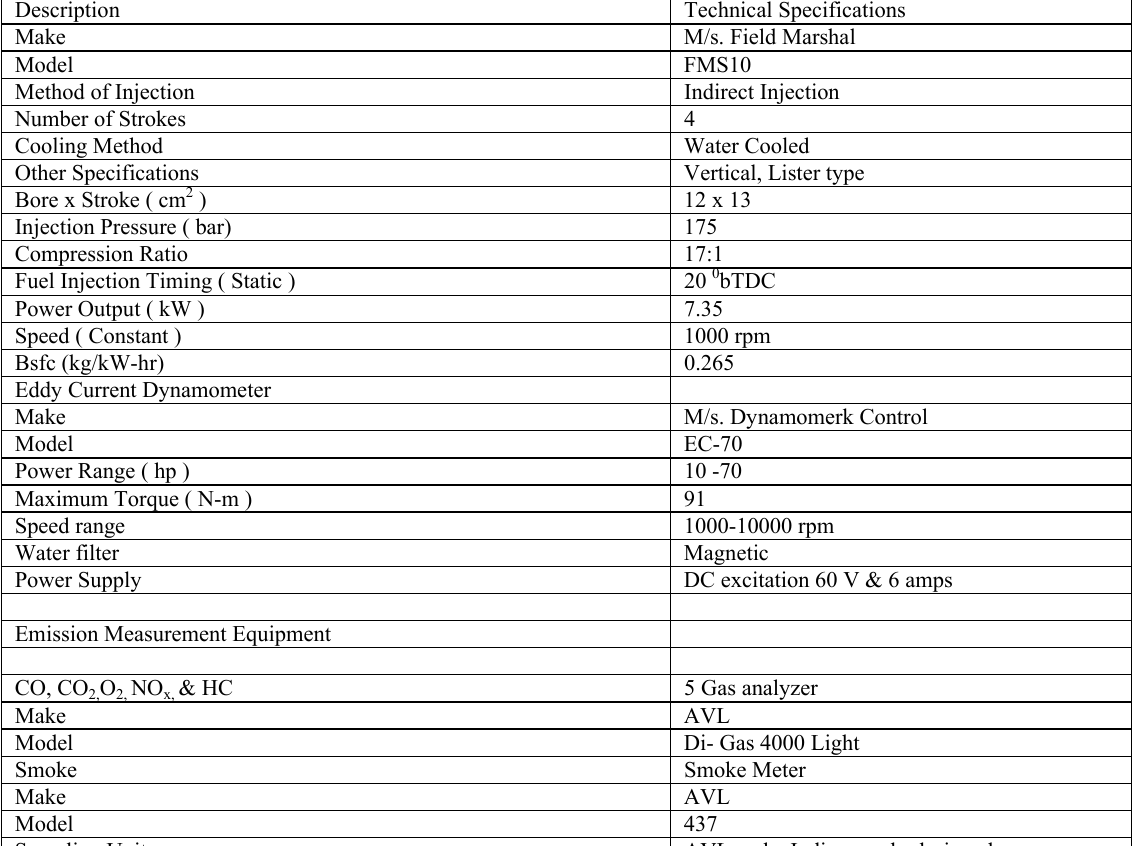
Figure 2. Free Fatty Acids Composition Table 1 Technical Specifications of Engine Test